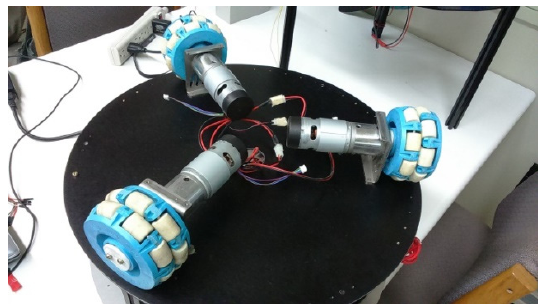
Figure 3. The three wheels of an omnidirectional WMR.